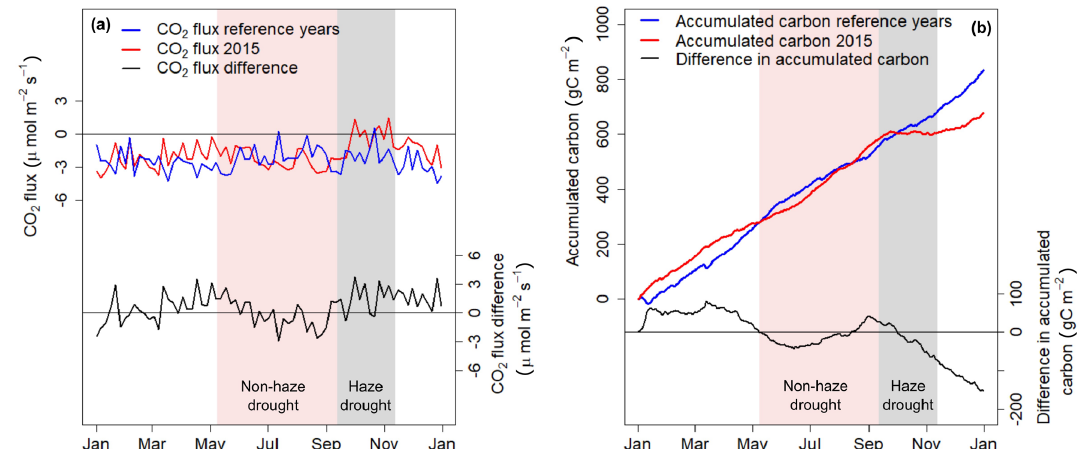
Figure 3. (a) The 5d running mean of net ecosystem CO 2 exchange (NEE) during 2015 and the reference time period and 5d running mean of CO 2 flux difference (2015 minus reference time period). (b) Accumulated carbon uptake derived from CO 2 fluxes during the period 2015 and the reference time period and differences in accumulated carbon between the two periods (2015 minus reference time period). Shaded areas in red and grey mark the non-haze drought and the haze drought period in 2015, respectively.